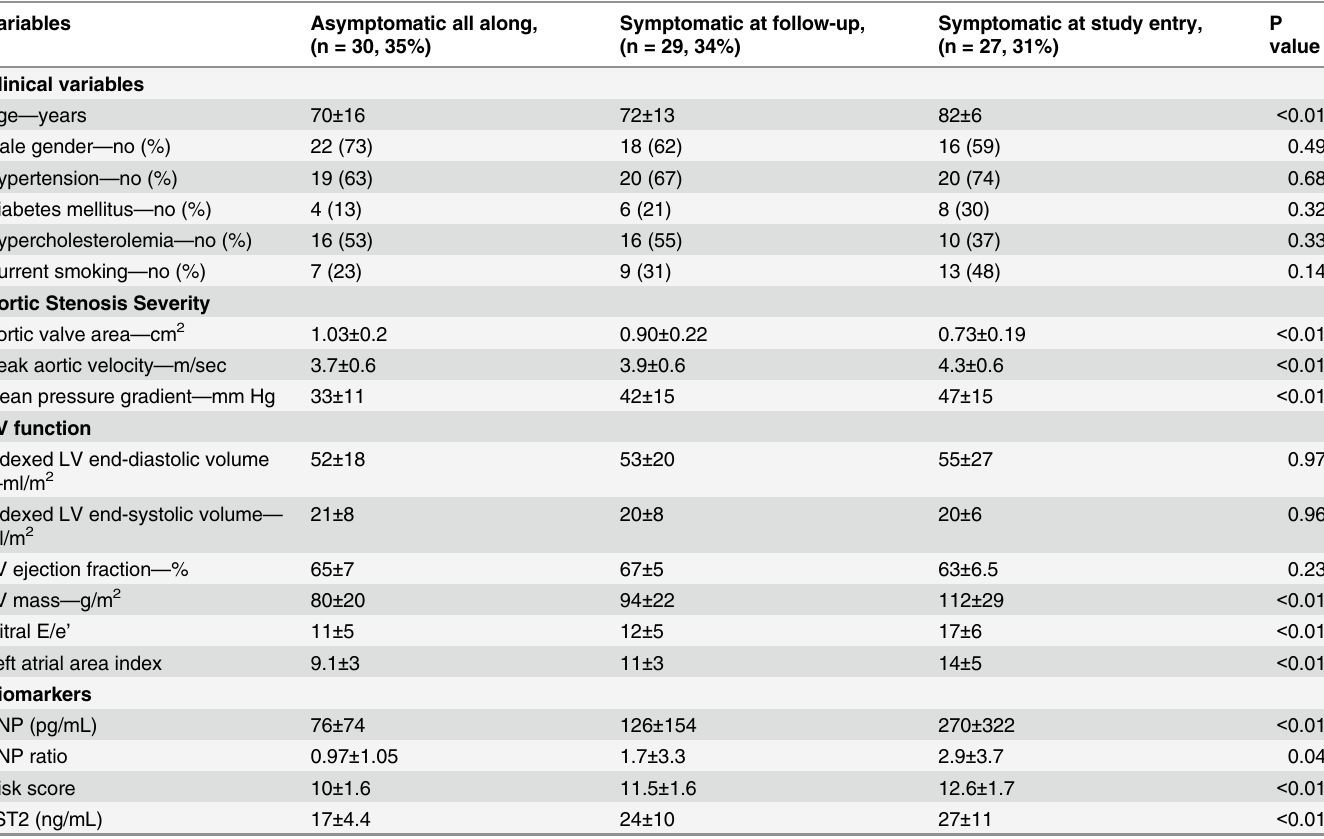
Table 1. Demographic, Clinical and Echocardiographic characteristics according to the symptomatic status at study entry and